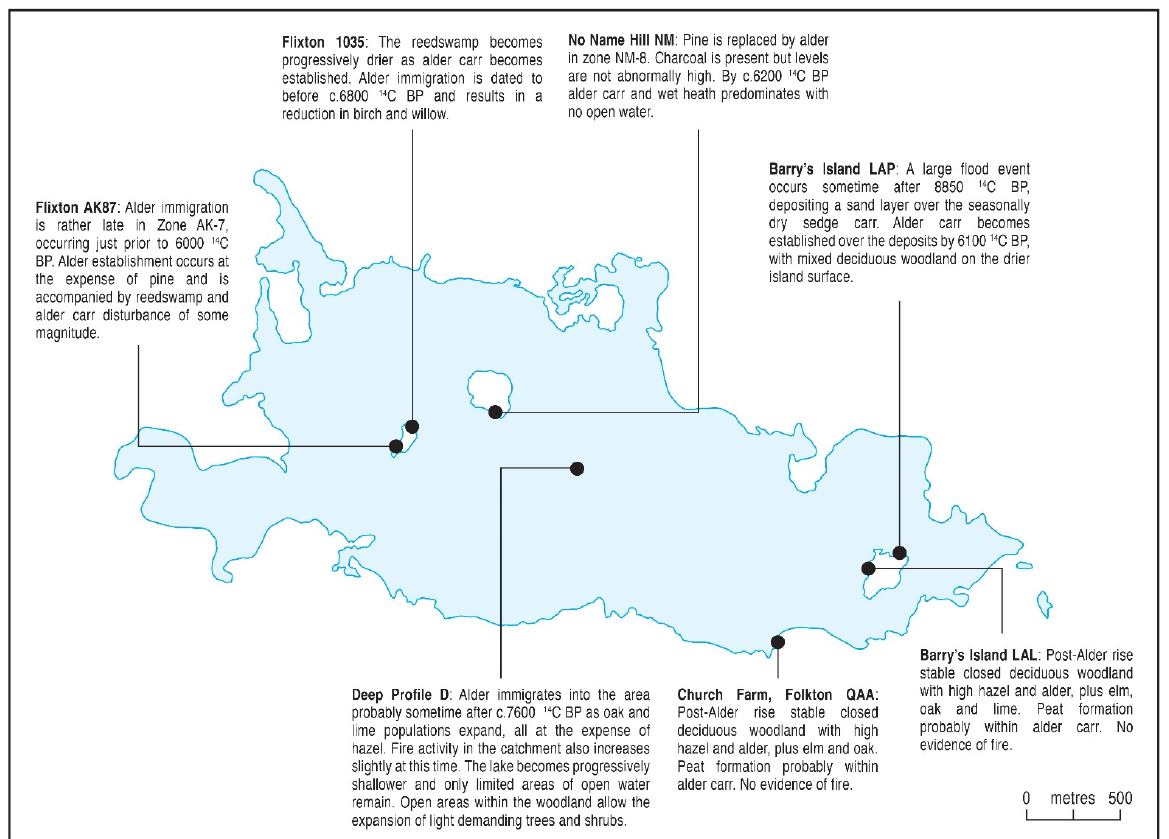
Figure 16. Correlation of palaeoenvironmental change at Palaeolake Flixton c.7000–5000 14 C BP (Mid-Holocene–cf. Atlantic), derived from zones D 8, NM 7, AK87 8, 1035 5, QAA 7, LAL 1 and LAP